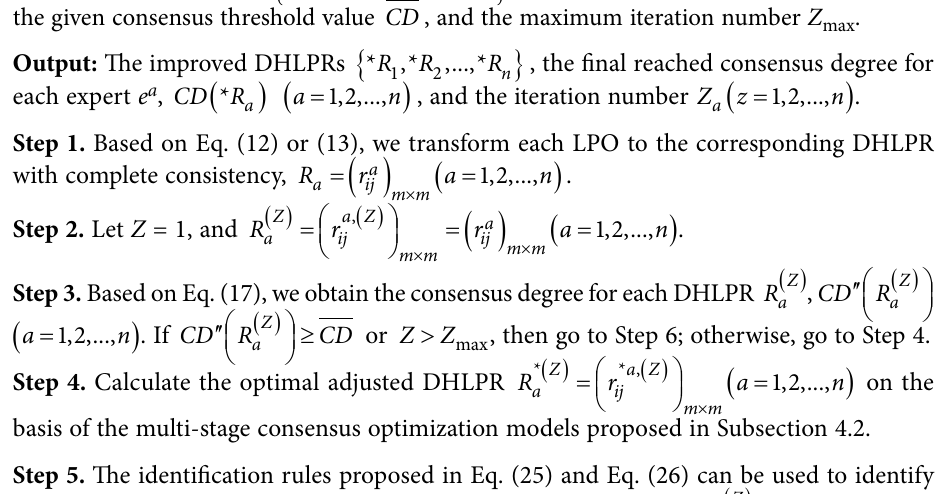
Algorithm 1. A multi-stage interactive consensus reaching algorithm with